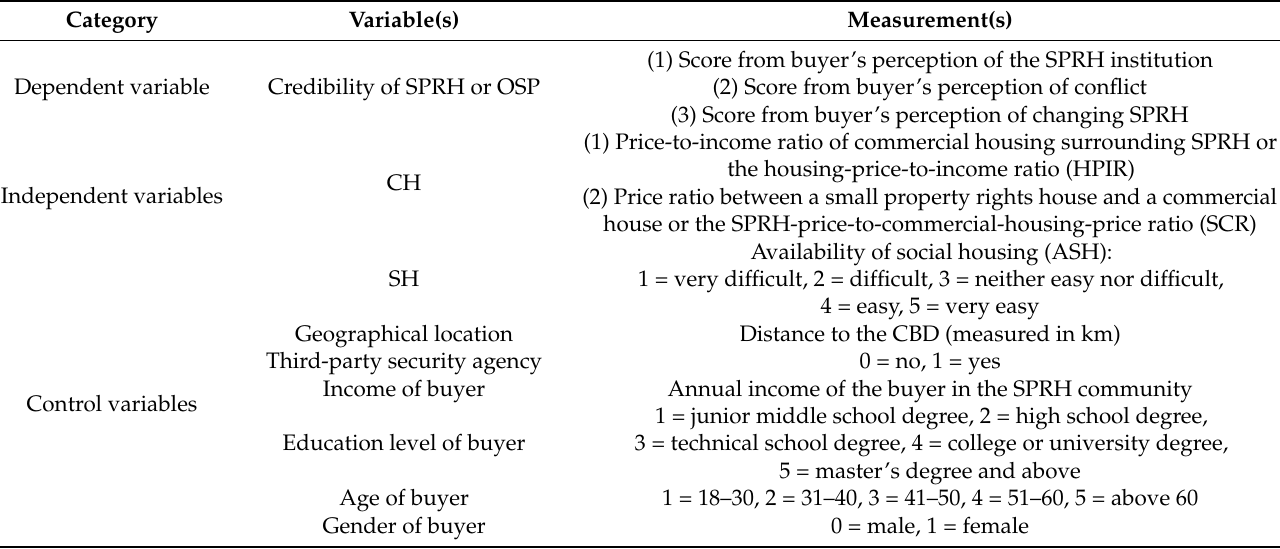
Table 1. Components and measurements of the